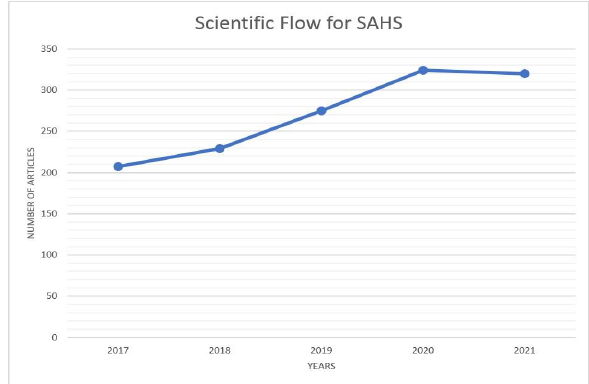
Figure 3. Number of articles published on SAHs.